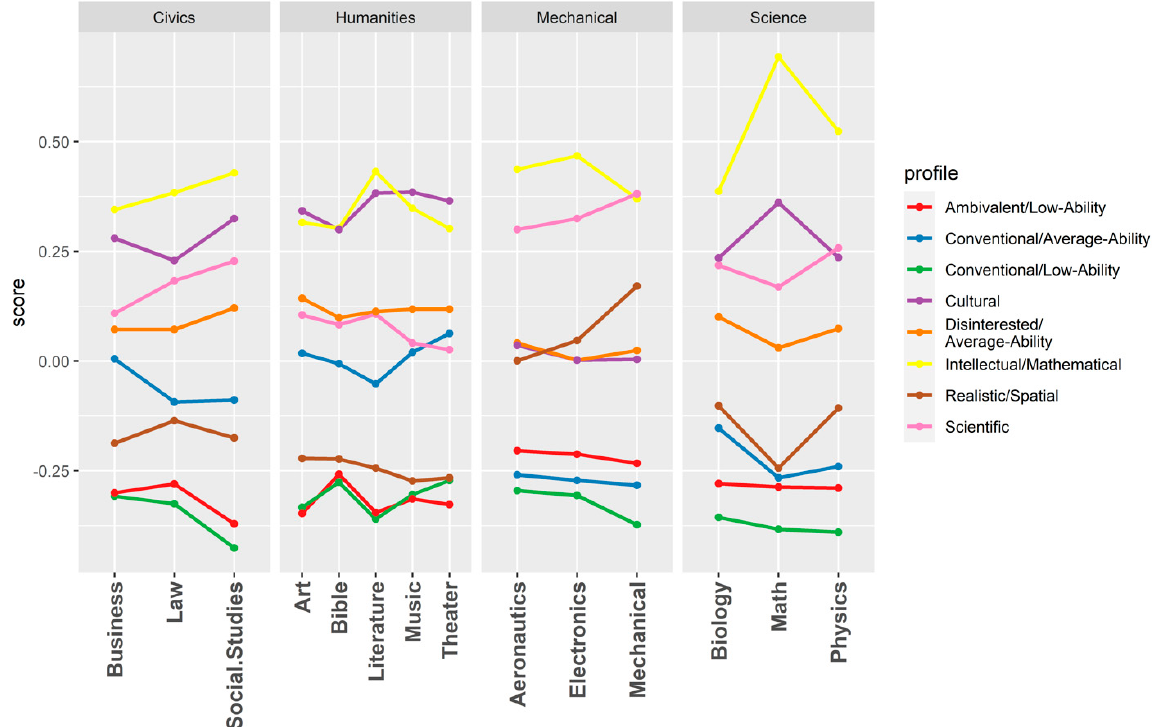
Figure 2. Trait profile knowledge scores by domain. Note: Scores on the y-axis are standardized beta coefficients. These scores are calculated by regressing each knowledge domain on profile membership scores for each profile. Standard errors ranged from 0.001 to 0.002.